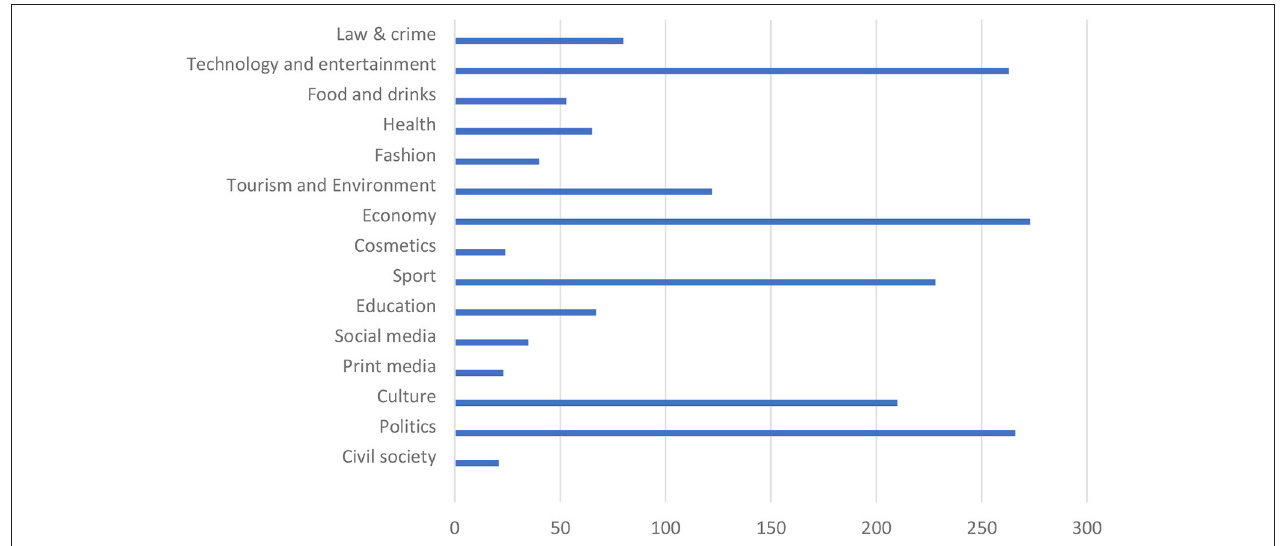
FIGURE 4 | Semantic